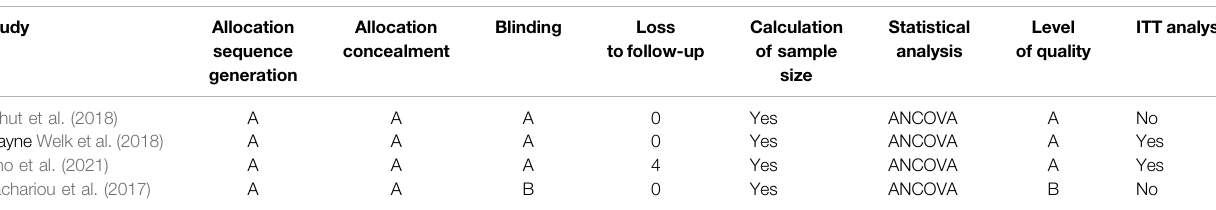
TABLE 3 | Quality assessment of individual